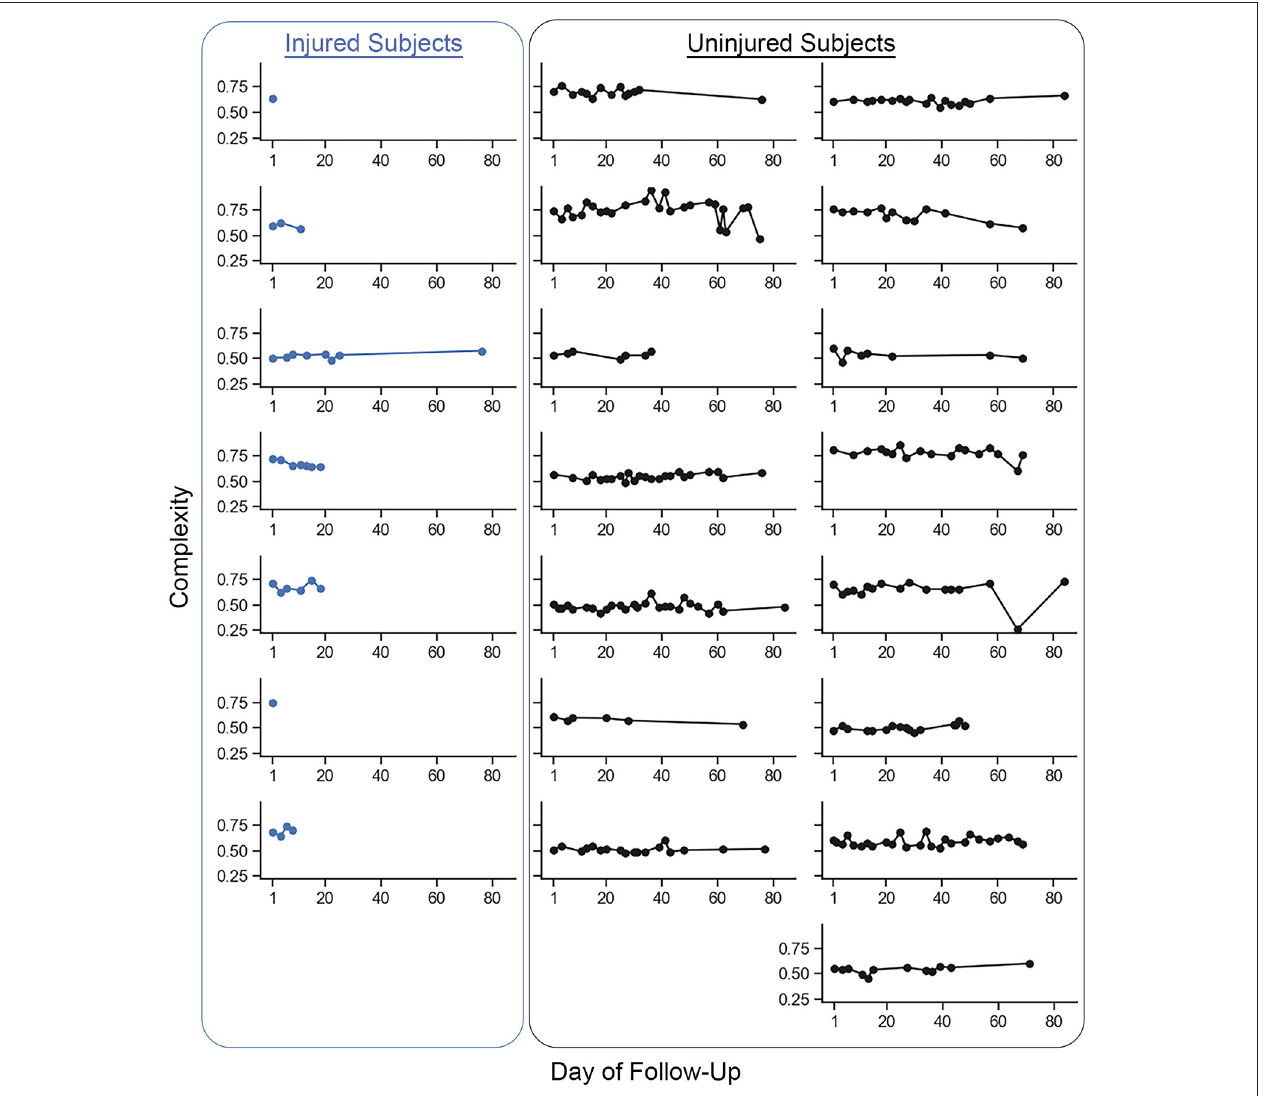
FIGURE 3 | Individual mean complexity values for each recorded run across participants from the baseline run to the last recorded run. Each dot represents the mean complexity value of a single recorded run from an individual participant. The injured group participants are represented in the column of plots on the left. All other plots are the uninjured group participants. The last recorded run for the injured group was the last run recorded prior to the reported running-related injury (i.e., ‘pre-injury’). Two participants in the injured group reported a running-related injury prior to recording a second run and so only one run is presented. Changes in complexity within participants were small on a per-unit basis (mean ± 1 standard deviation change (i.e., pre-injury minus baseline) in run-to-run complexity within a given participant was − 0.0031 ± 0.0085 units. The between-participant standard deviation (0.0871 units) in run-to-run complexity magnitude was more than 60% larger than the within-participant standard deviation (0.0529